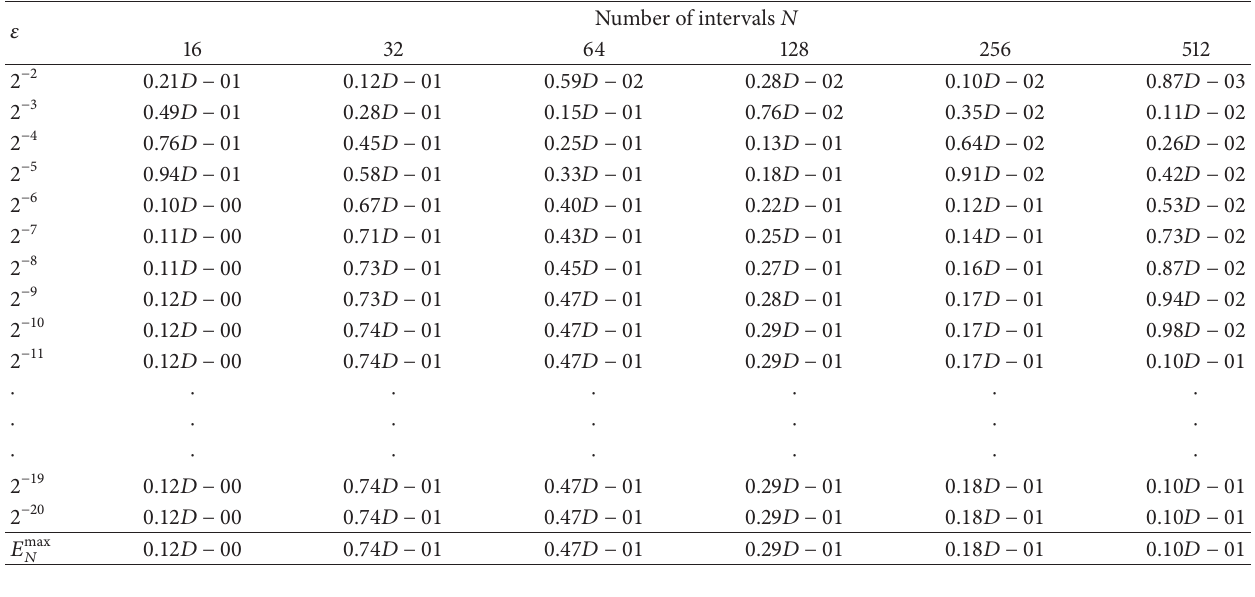
Table 2: Convergence rates.